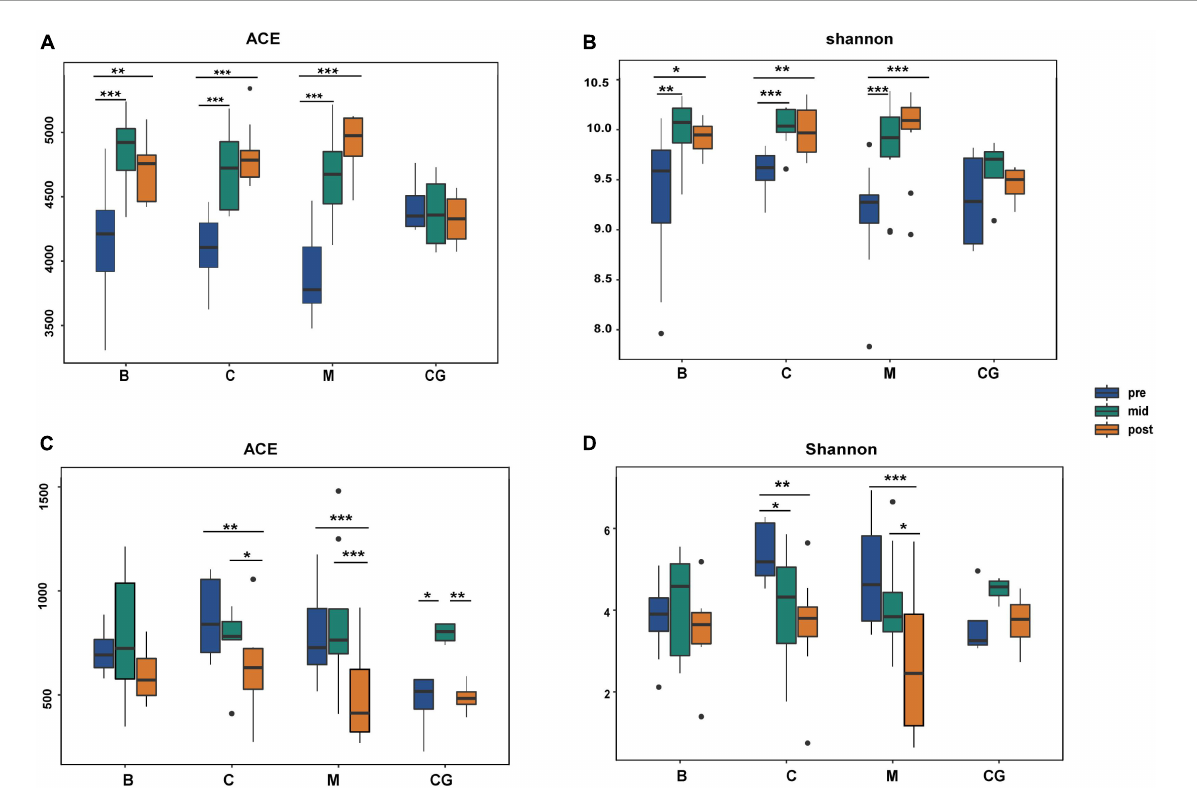
FIGURE5 Alpha diversity of bacterial and fungal communities according to nest material composition and incubation period. (A,B) Bacterial alpha diversity indexes; (C,D) fungal alpha diversity indexes; ns: p > 0.05; * p < 0.05; ** p < 0.01; *** p < 0.001. B, bamboo leaf; C, couch grass; M, mixed litter; pre, pre-incubation period; mid, mid-incubation period; post, post-incubation period.